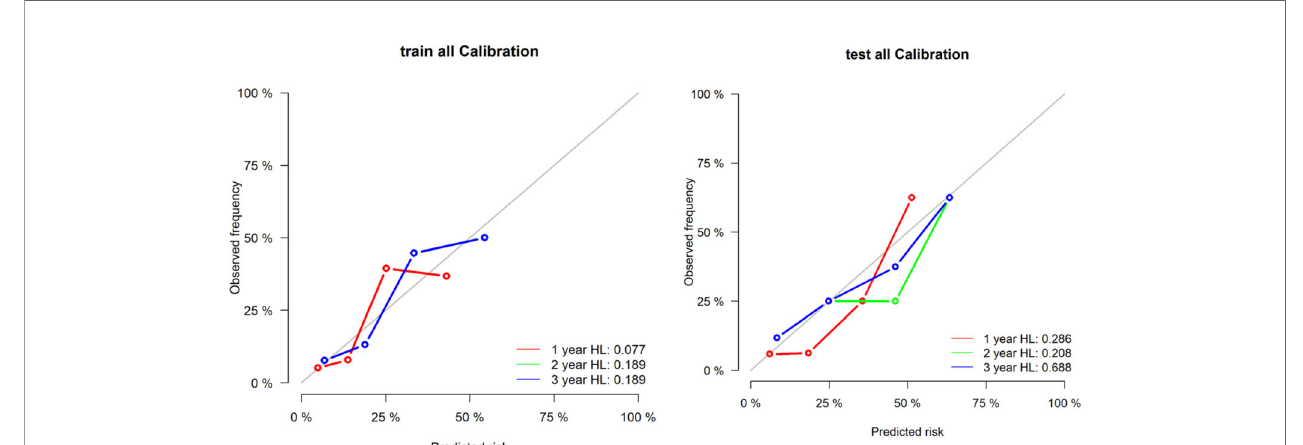
FIGURE 2 | Calibration curves of the radiological label were plotted to assess the agreement between LRFS predicted by the model and the observed LRFS.